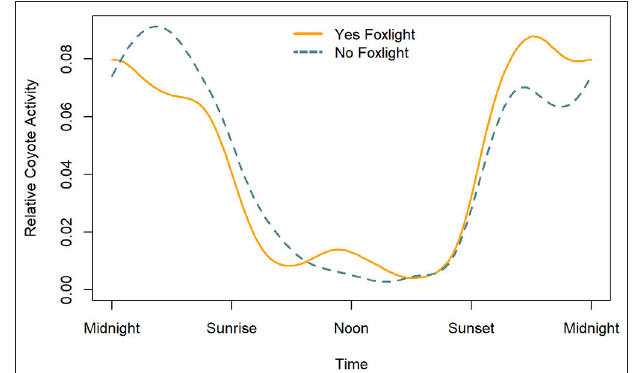
FIGURE 4 | Relative coyote activity by time of day. The lines represent the density of 24-h coyote diel activity across all periods with active Foxlights and inactive